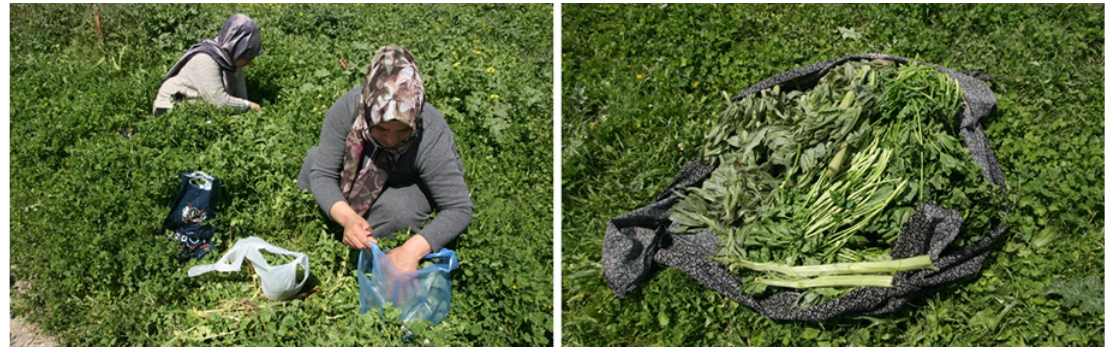
Fig. 6 At the beginning of April, local people collect wild edible plants in Hasankeyf.